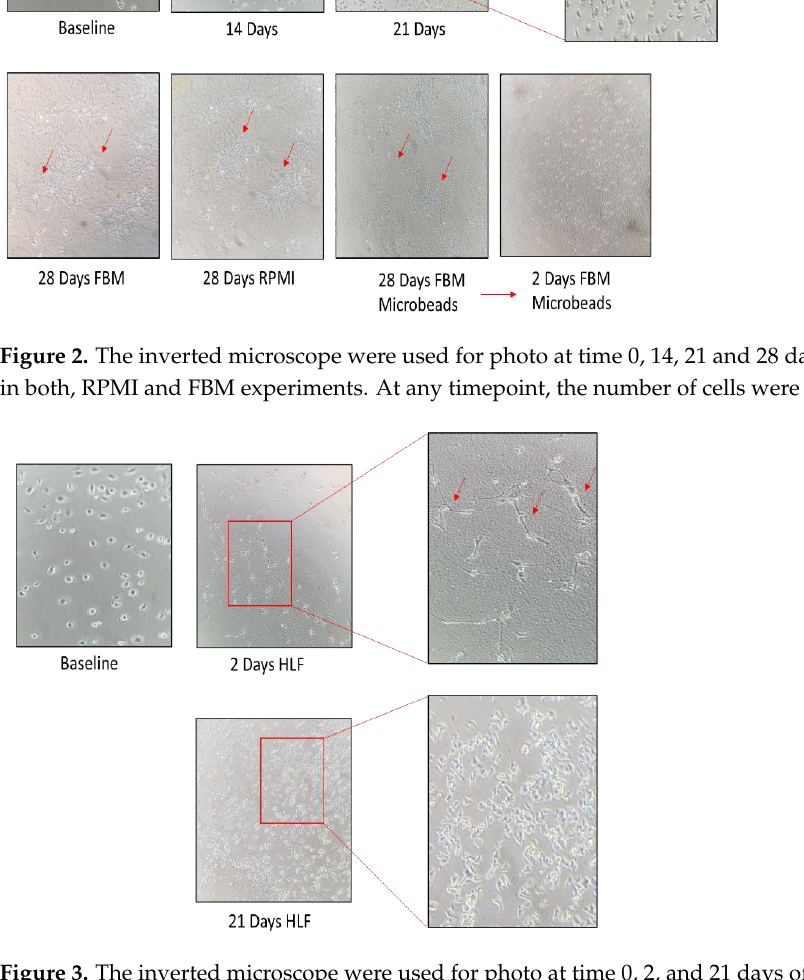
Figure 3. The inverted microscope were used for photo at time 0, 2, and 21 days of HLF cell cultures At any timepoint, the number of cells were counted. Spindle shaped cells was observed after two days of seeding.